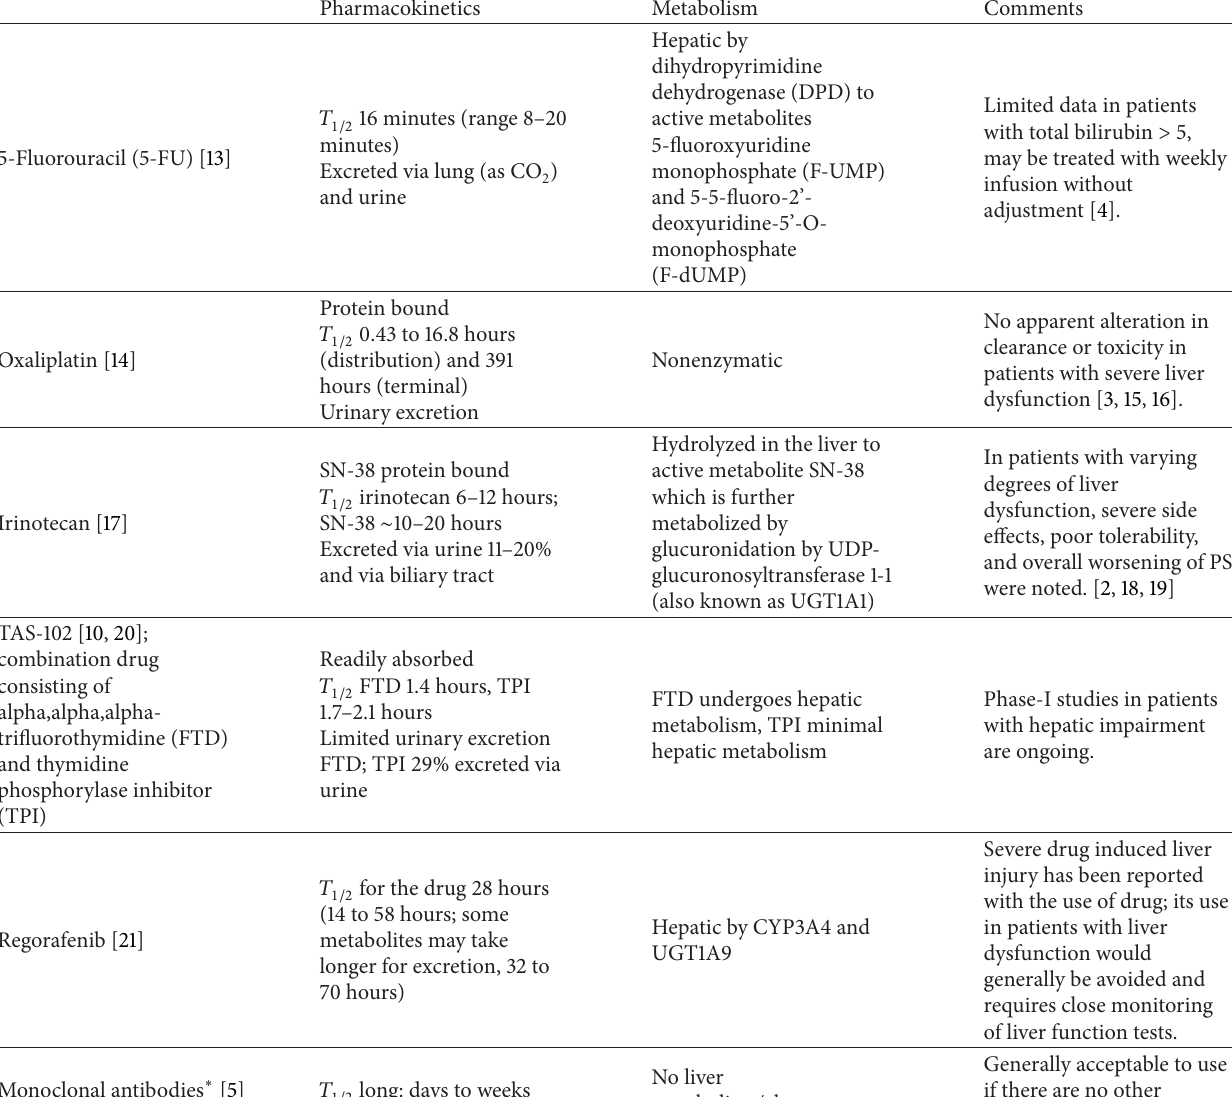
Table 2: List of chemotherapeutic and biologic agents for patients with